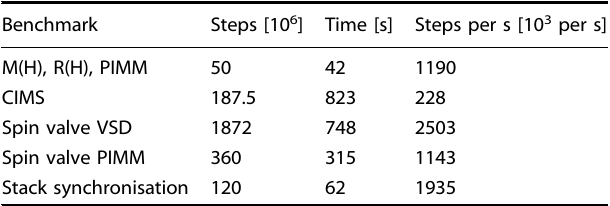
Table 1. Example of serial execution times and the number of steps per